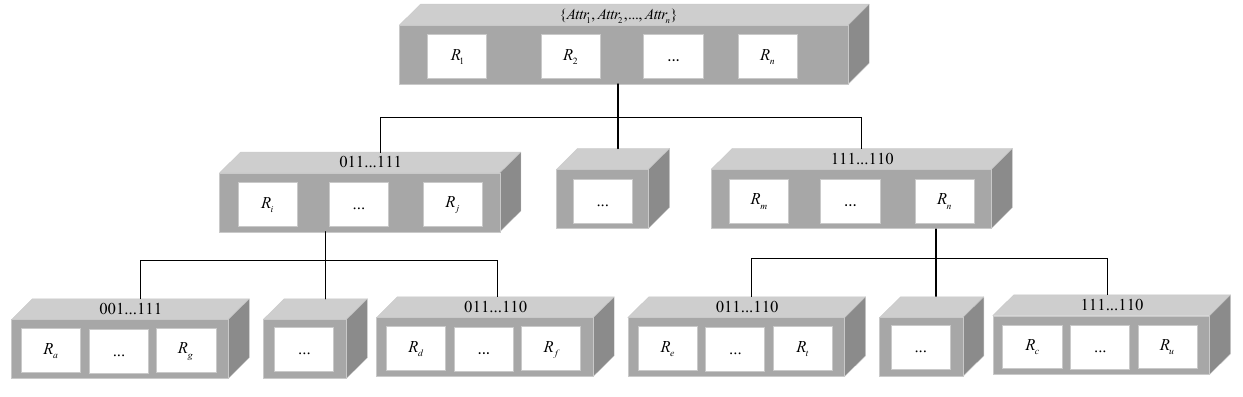
Figure 3. A tt ribute coding. Figure 3. Attribute